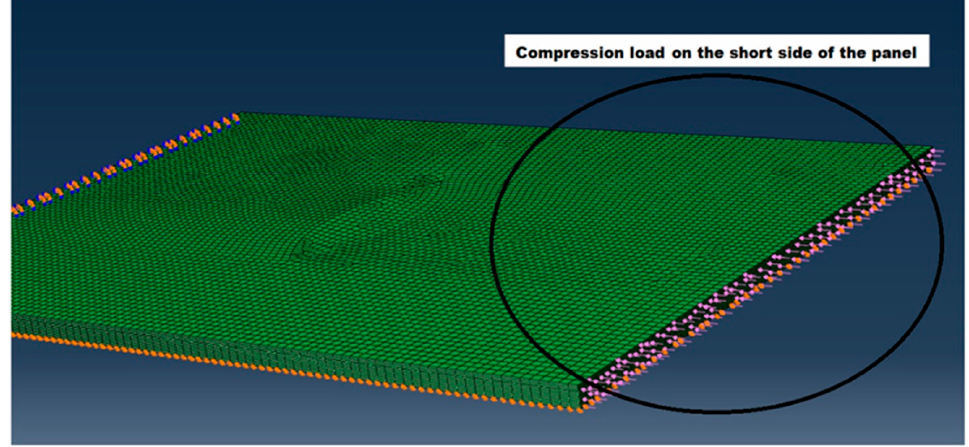
Figure 9. Compressive load applied.